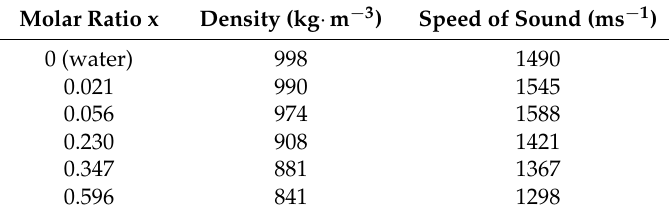
Table 1. Density and speed of sound of a mixture of water and 1-propanol at different molar ratio x. Molar Ratio